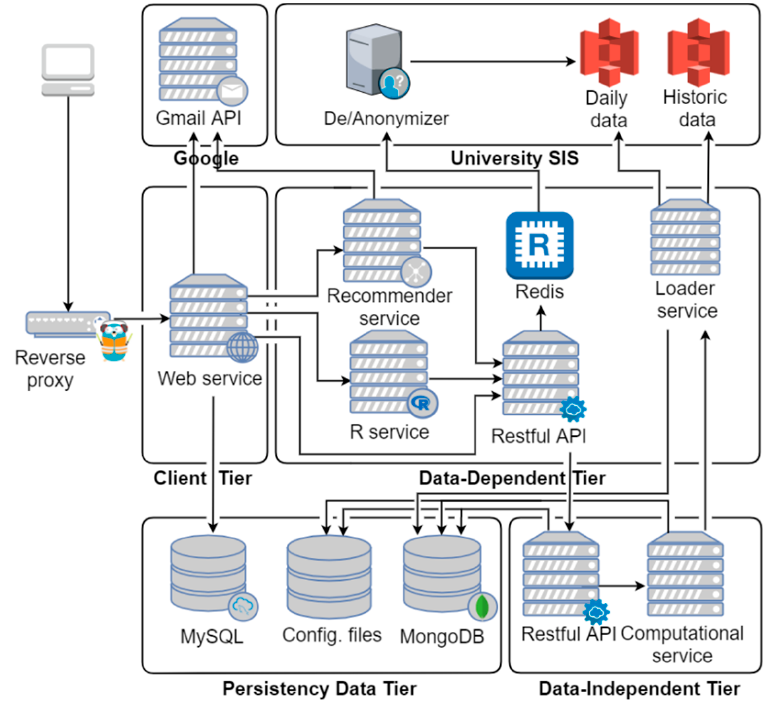
Figure 2. Insfrastructure of the predictive system.